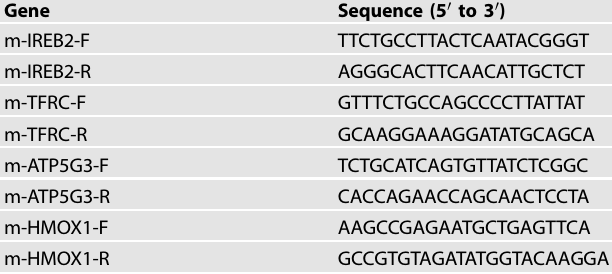
Table 2. The primer sequences of target